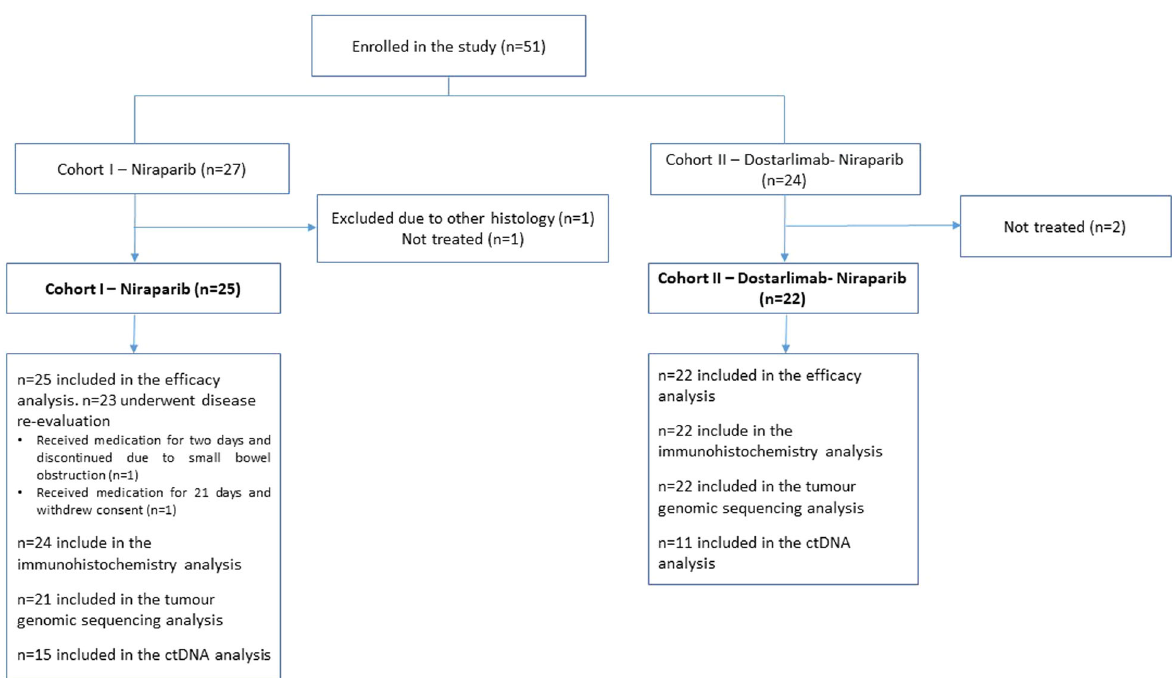
Fig.1|CONSORT fl owdiagramofpatientsenrolledinthestudy. Resultsareshownpercohort,includingthenumberofpatientsevaluatedforef fi cacyandtranslational studies.